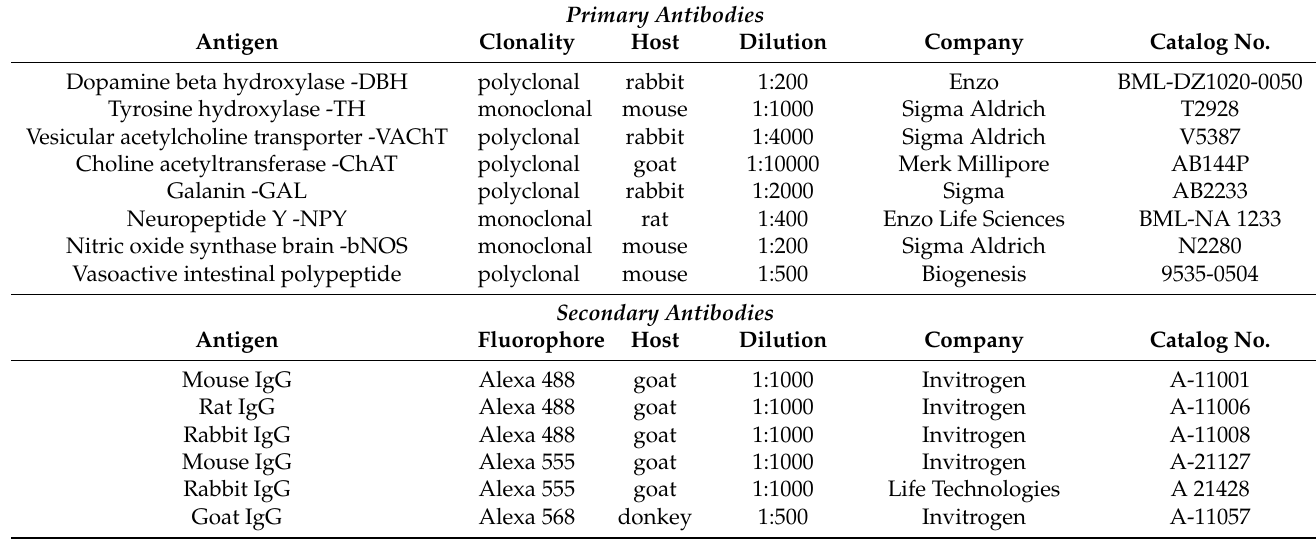
Table 1. Antisera used in the study. Primary